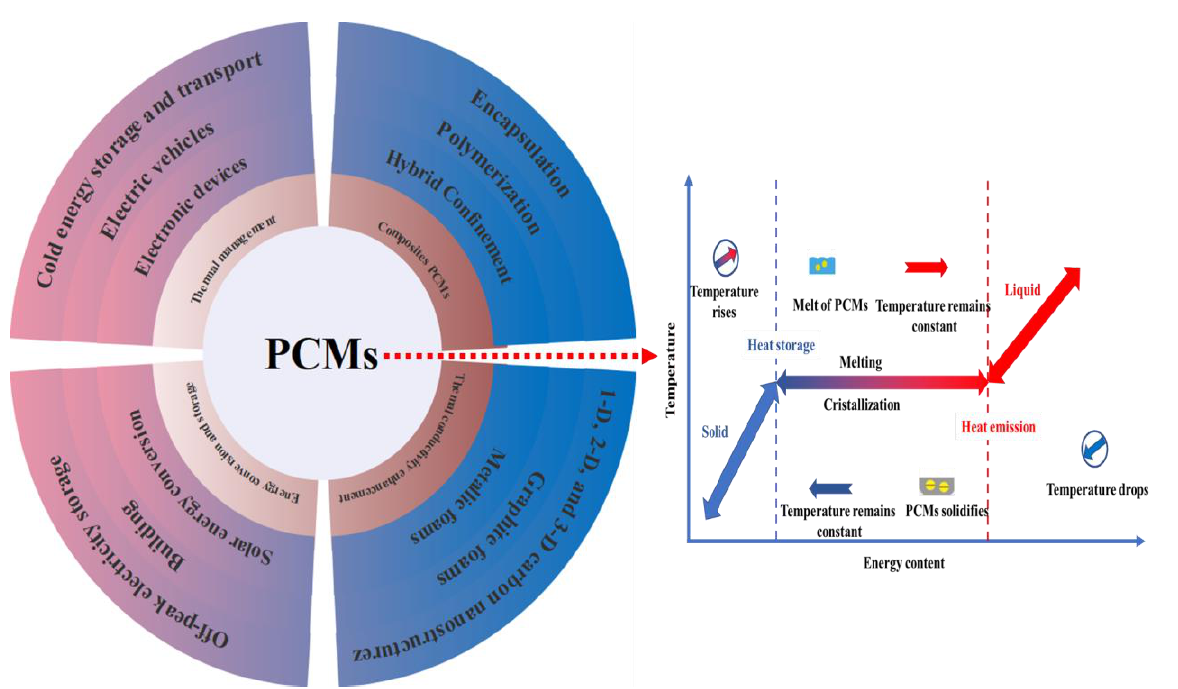
Figure 2. Form-stable PCCs integrated diagram, encompassing preparation processes, enhancement of thermal conductivity techniques, and their applications.